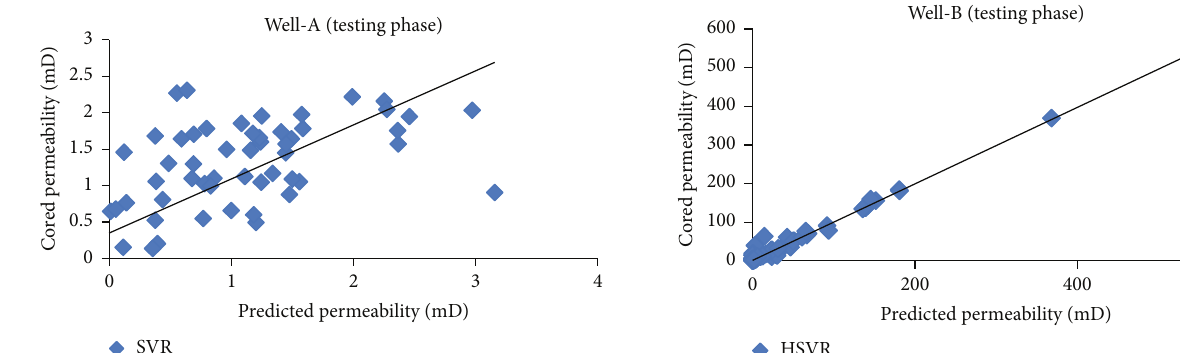
Figure 15: Cross plot of cored and predicted permeability for HSVR model.